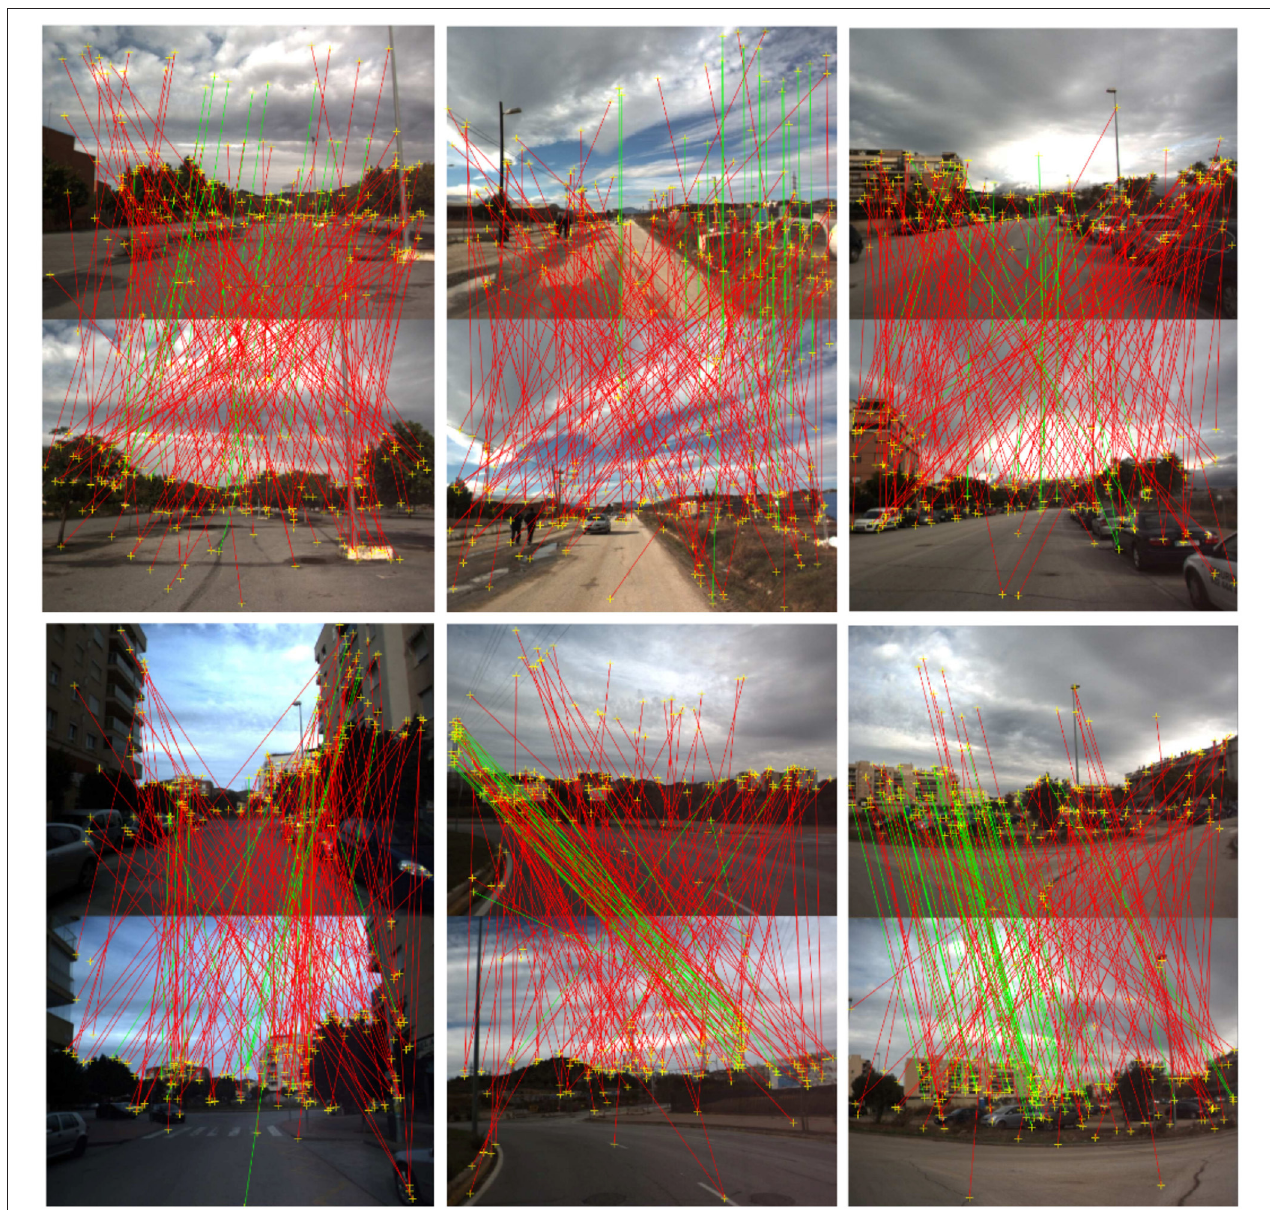
FIGURE 7 | Inliers and outliers in five scenes of the Malaga dataset. The green lines represent correct correspondences and the red lines denote mismatches. In each pair of scenes, the scene below moves from above. Better viewed in color.